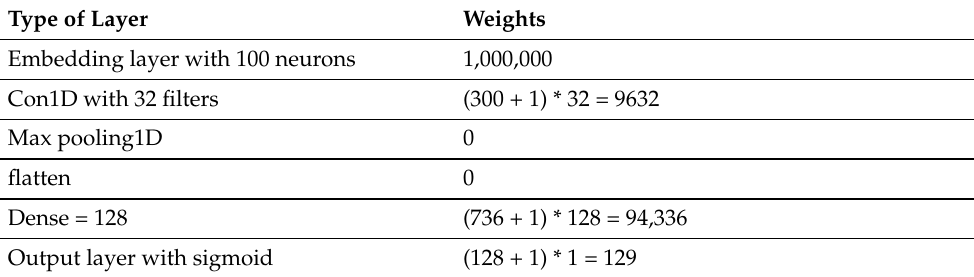
Table 5. Layered-wise details for